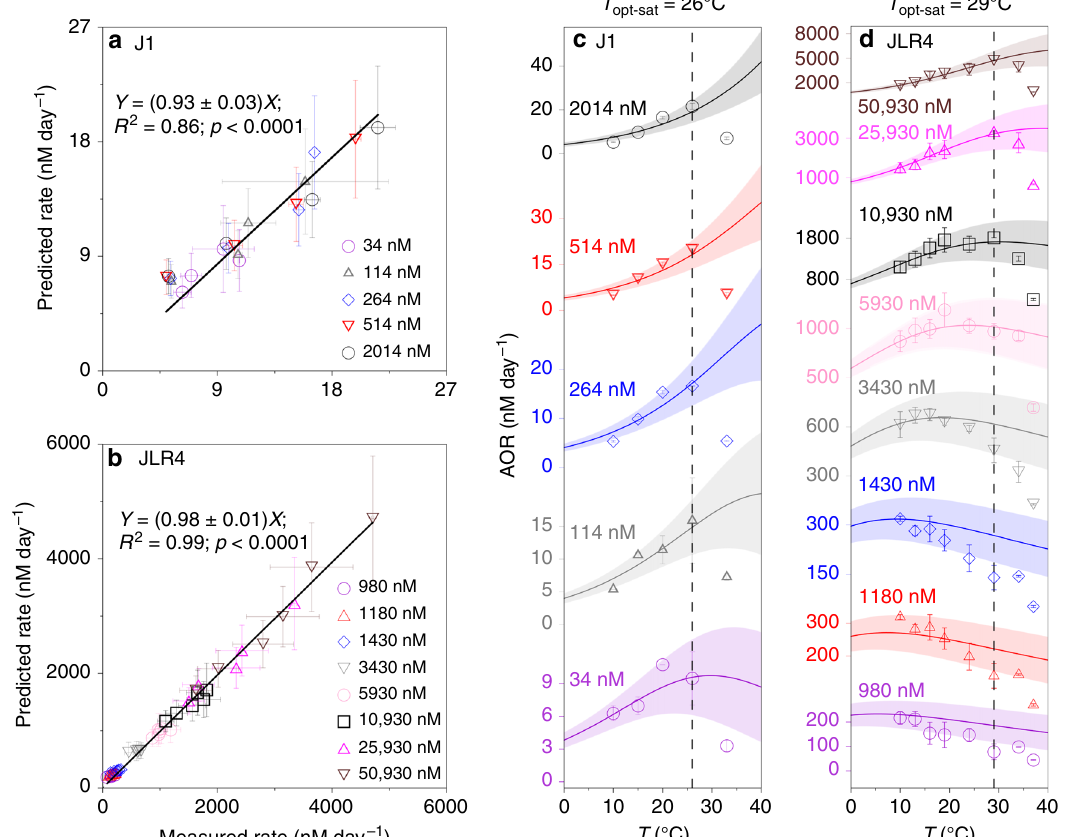
Fig. 3 Validation plot for the rate predictions and observations. a , b Scatter plot of the predicted rates via the Dual Arrhenius and Michaelis – Menten kinetics model (DAMM model) and the measured rates under different substrate concentrations and temperatures (below the optimum temperature in substrate-saturated conditions, T opt-sat ). Linear regressions between the model predictions and the measurements are presented (two-sided t test was used to generate the p value (95% con fi dence) to measure the strength of correlation coef fi cient. p values are uncorrected). c , d The rate patterns (dots) against temperature under different substrate concentrations. Curves stand for the predicted rates derived from the DAMM model and the symbols represent the measured rates. The shades denote the uncertainty of model prediction. The dashed black vertical lines represent the T opt-sat . The measured rates in ( a , c ) are presented as mean values, instead of standard deviation the given bars indicate the variation range of two independent experiments. The measured rates in ( b , d ) and the predicted rates in ( a – d ) are expressed as the mean values ± SD ( n = 10 in ( a , c ); n = 48 in ( b , d ); independent